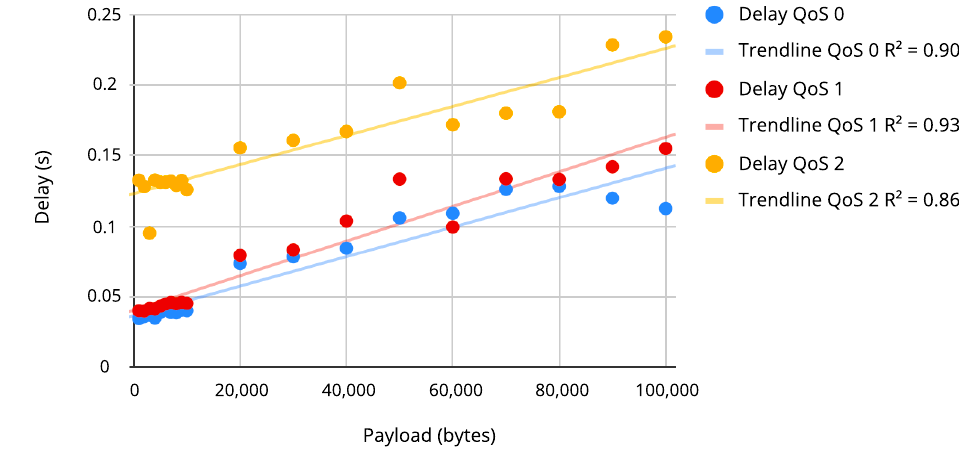
Figure 9. Payload × Delay on Wi-Fi connection.